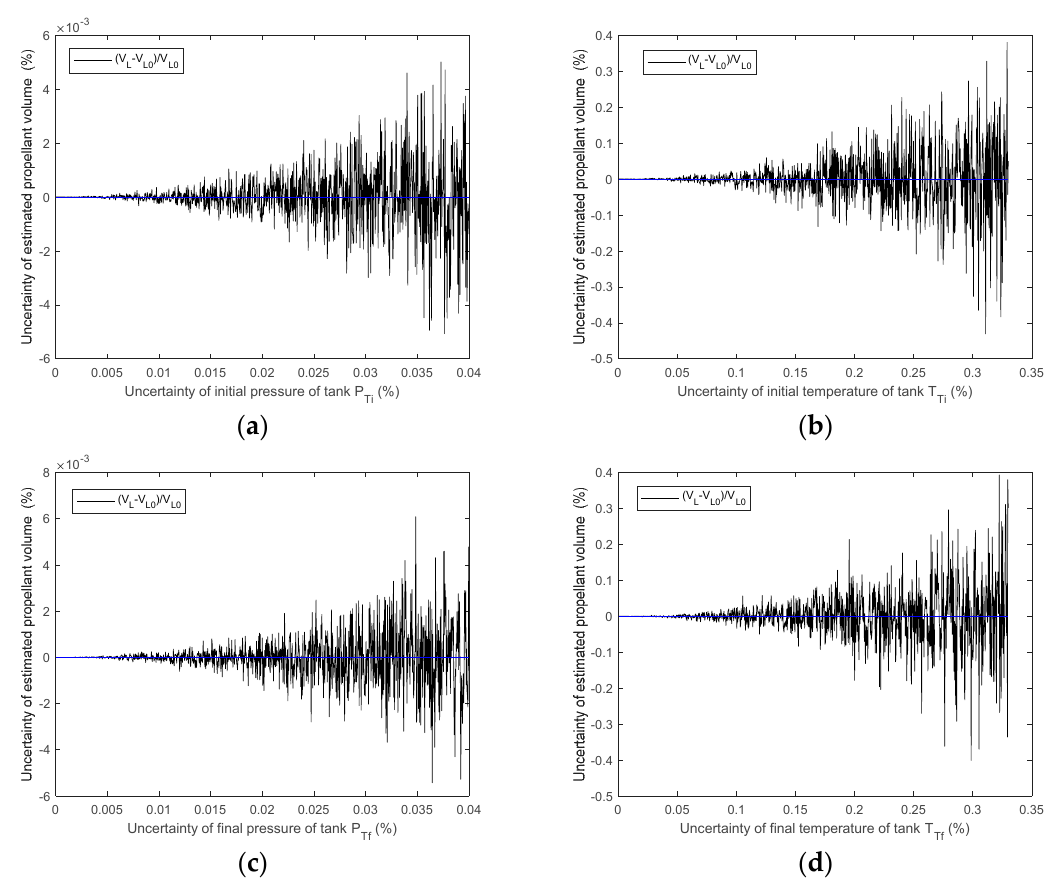
Figure 3. Effect of the improved measuring uncertainties in the tank on the final measuring uncer- tainty(( a ) is of the initial pressure of the tank, ( b ) is of the initial temperature of the tank, ( c ) is of the final pressure of the tank, and ( d ) is of the final temperature of the tank).